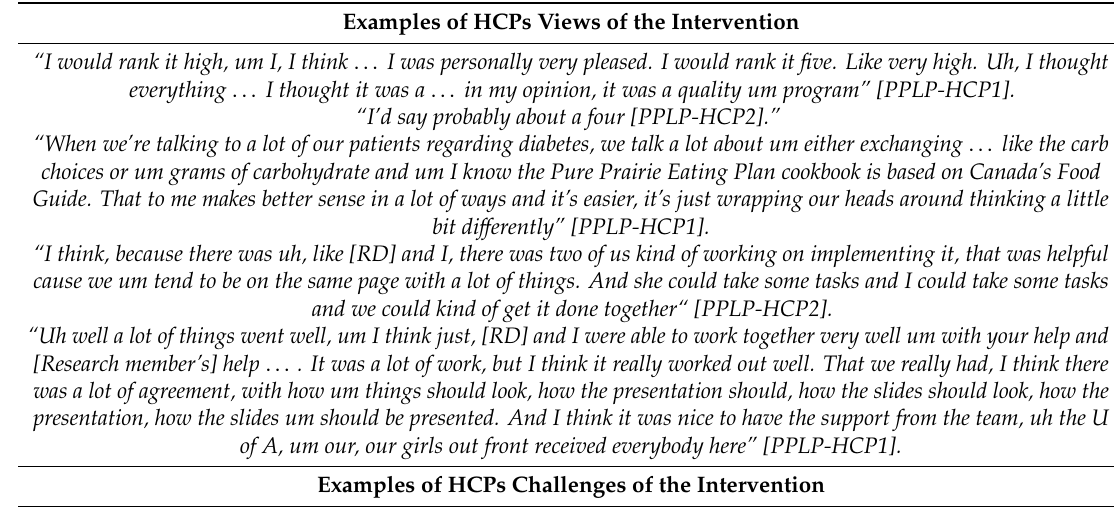
Table 7. Qualitative analysis, representative quotes of health care providers